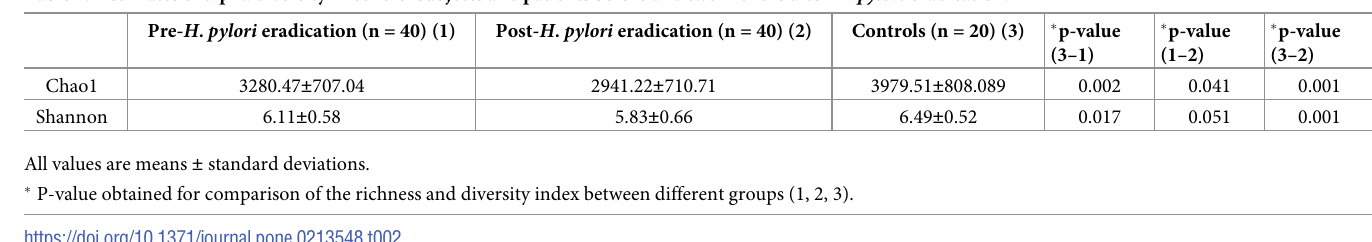
Table 2. Estimates of alpha diversity in control subjects and patients before and two months after H . pylori eradication. Pre- H . pylori eradication (n = 40) (1)